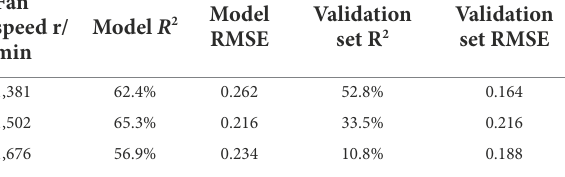
TABLE 5 R 2 and RMSE of the airflow speed loss rate model under different fan speeds. Fan speed r/